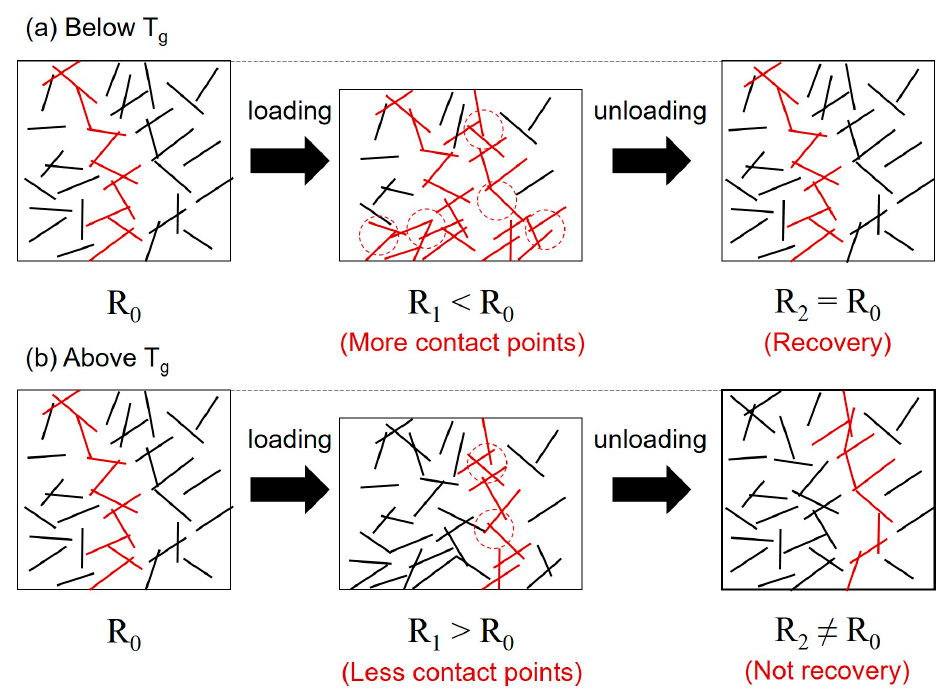
Figure 7. Schematic illustration of microstructure of CNT / epoxy composite ( a ) below the glass transition temperature and ( b ) above the glass transition temperature.